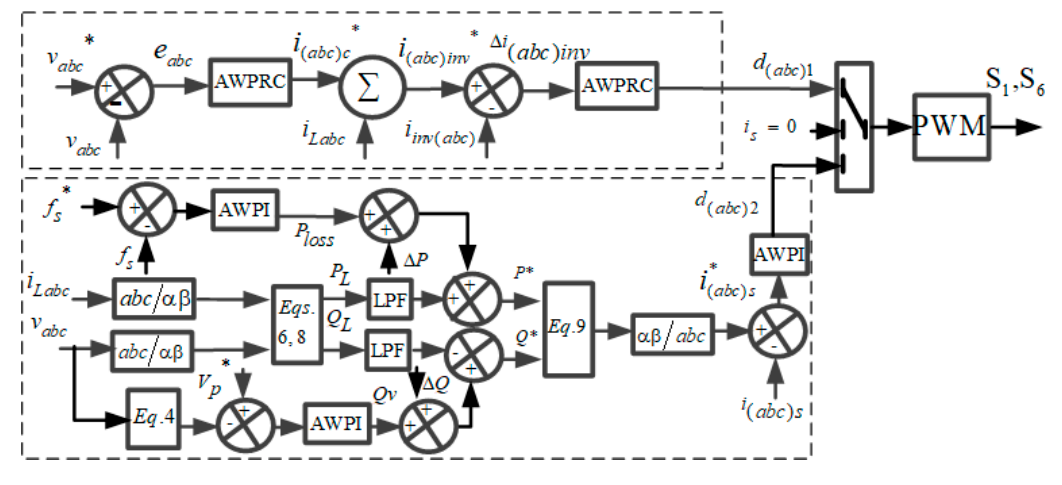
Figure 10. Control for interfacing inverter.